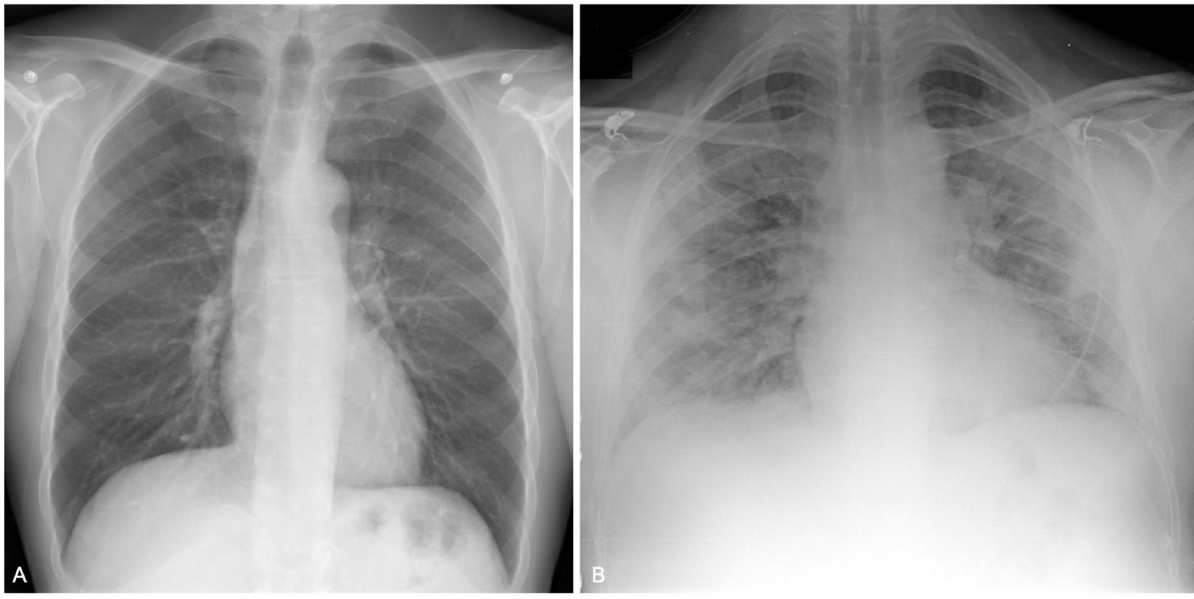
Fig 1. Examples of a chest severity score. A. Chest radiograph of a 48-year-old male. CXR does not show any opacities; total score = 0. B. CXR of a 42-year-old male shows opacities in all three right lung zones and in the left middle and lower lung zones; total score = 5.